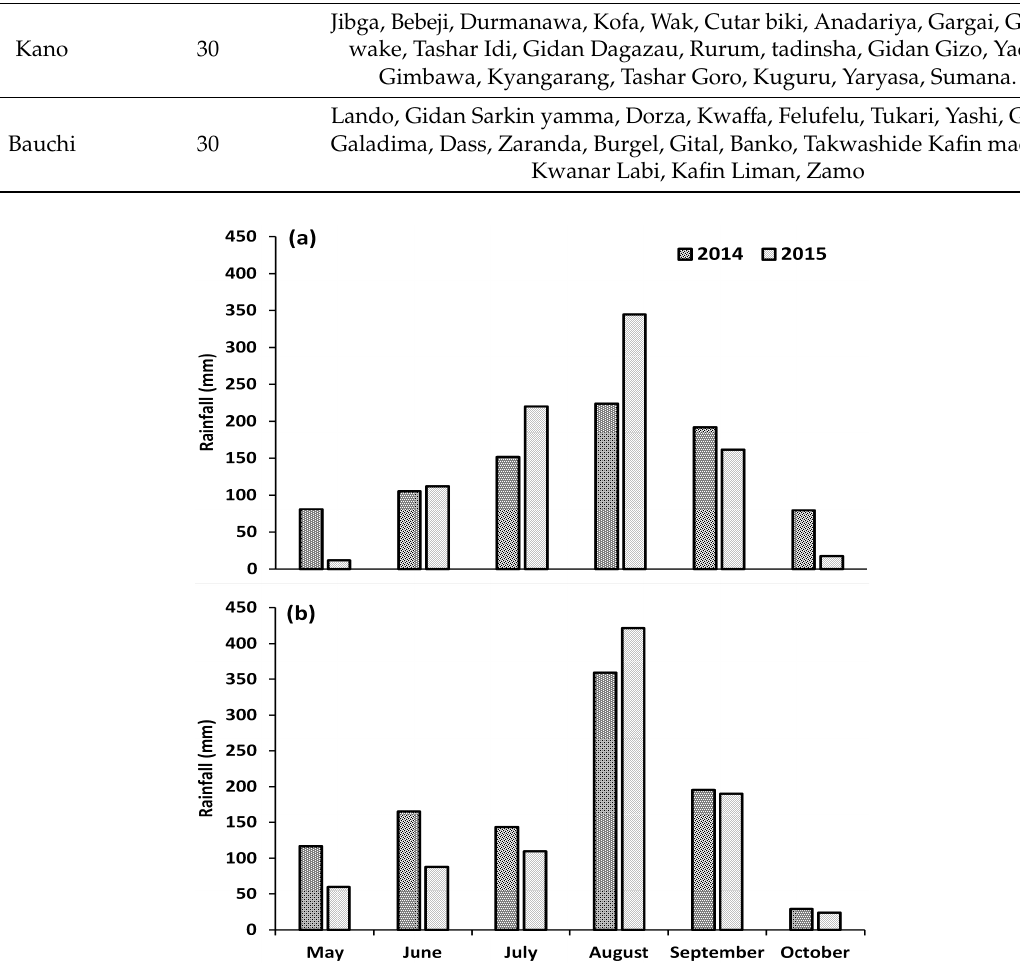
Figure 1. Average monthly rainfall in communities at Kano ( a ) and Bauchi ( b ) in 2014 and 2015.